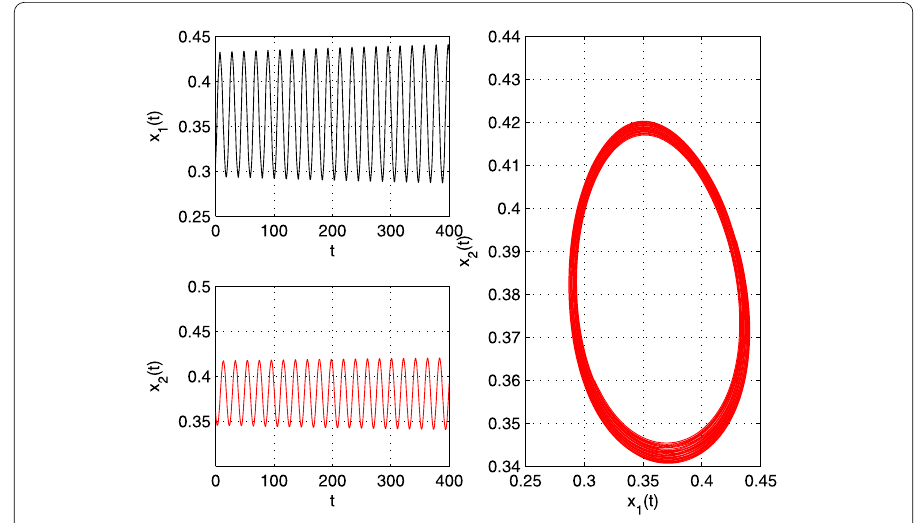
Figure 3 The trajectories of system (4.1) with τ = 0.44. A periodic solution bifurcates from the equilibrium E ∗ 3